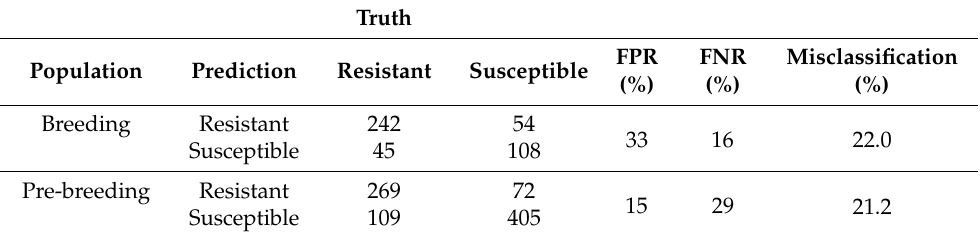
Table 5. Accuracy and area under curve values for training and testing sets in the breeding and prebreeding populations. Table 6. Confusion matrix from the logistic regression model for the testing set in breeding and pre-breeding